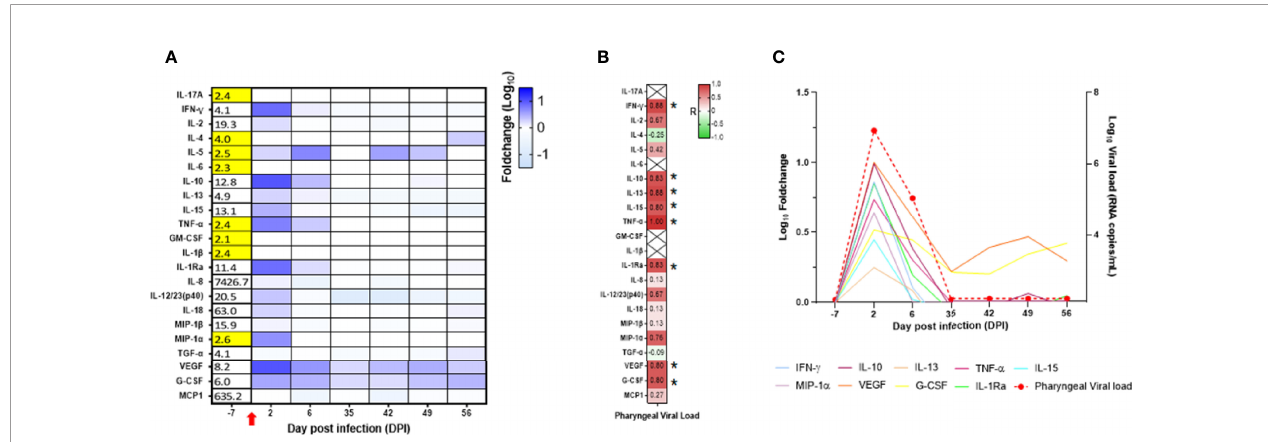
FIGURE 8 | Cytokine analyses in the neonate blood. (A) Heatmap representing the evolution of cytokines over time (in the log of fold change from the baseline). Variations are shown on a blue scale. Basal concentrations (pg/ml) are shown on the left side of the heatmap. Highlighted yellow values correspond to the detection threshold. (B) Spearman correlation analysis between SARS-CoV-2 viral RNA load in the oropharyngeal compartment neonate and the kinetics of cytokines in the blood. Correlation factors determined on the whole kinetics are shown on the heatmap with a red to green scale. * p < 0.03. (C) Graphs overlapping the kinetics of the blood cytokines in the log of fold change (left scale) with the oropharyngeal viral RNA load on the logarithmic scale (right